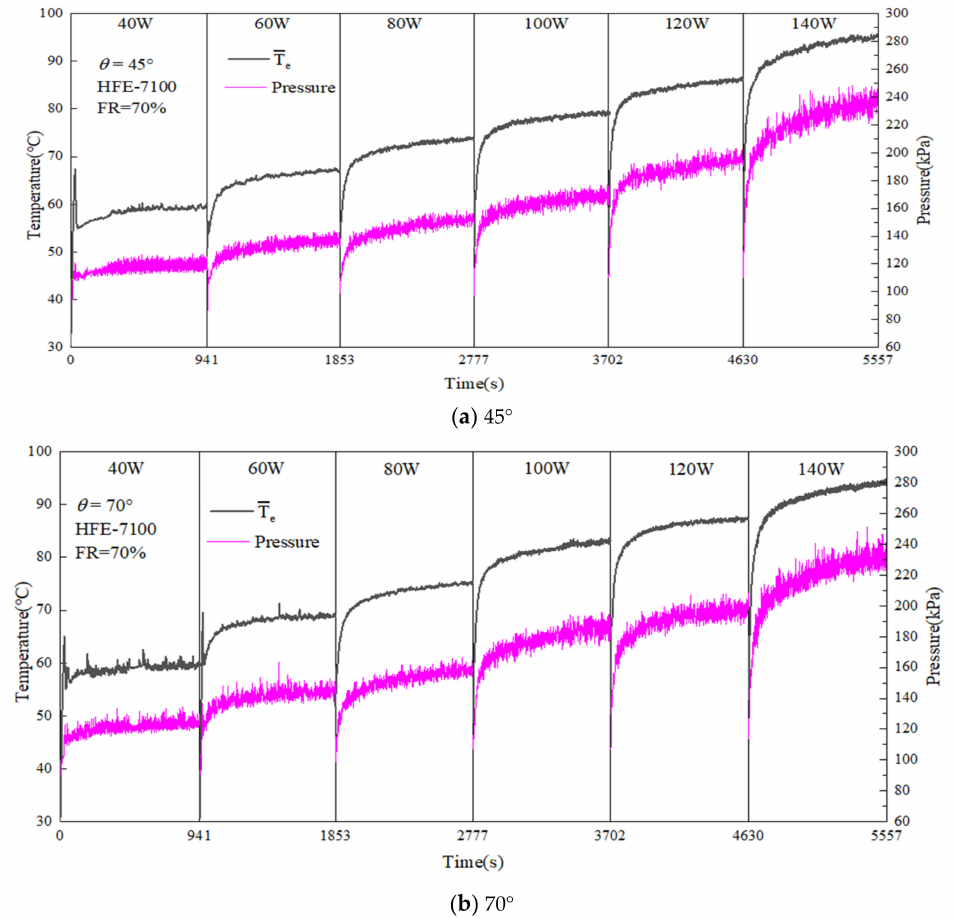
Figure 7. Variation of temperature and internal pressure of evaporation section with time under different installation angles of HFE-7100 working